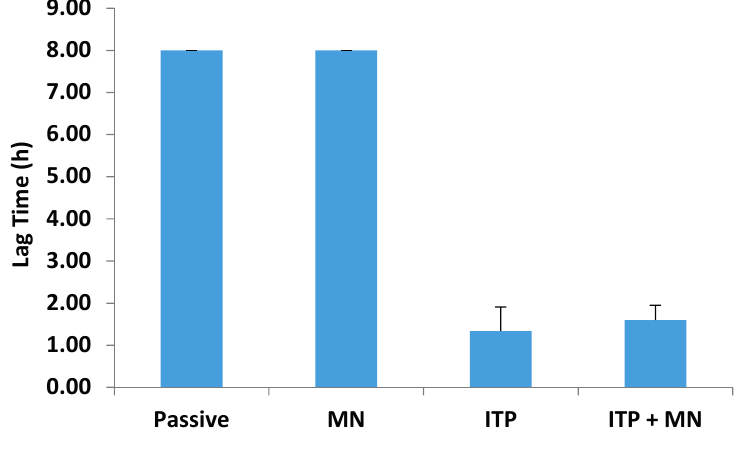
Figure 3. Lag time associated with passive and active delivery. All values represent mean ±